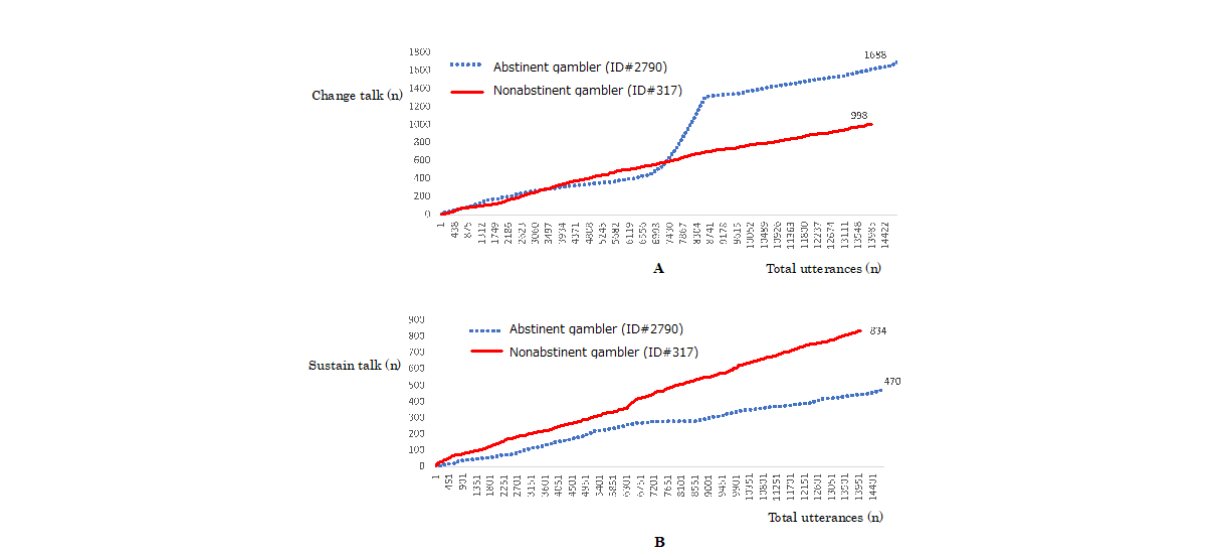
Figure 4. Dynamic differences in the change and sustain talks between abstinent and nonabstinent gamblers in web-based anonymous gambler chat meetings. Blue and red lines in A and B indicate abstinent (ID# 2790) and nonabstinent (ID# 317) gamblers, respectively. A: The accumulated number of change talks during web-based anonymous gambler chat meetings. The vertical and horizontal lines indicate the number of change talks and total utterances, respectively. B: The accumulated number of sustain talks during web-based anonymous gambler chat meetings. The vertical and horizontal lines indicate the number of sustain talks and total utterances,